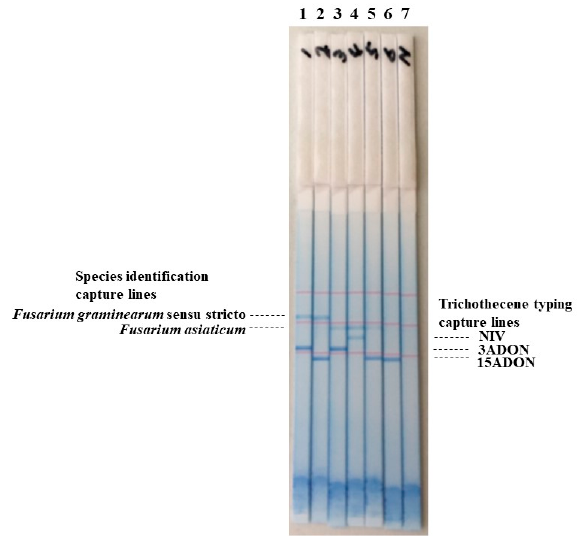
Figure 4. The dipstick DNA chromatography assay for species identification and trichothecene typing of the Fusarium graminearum species complex. Multiplex PCR solutions for species identification ( Fusarium graminearum sensu stricto [s. str.] and Fusarium asiaticum ) and trichothecene typing (3-acetyl deoxynivalenol, 3ADON; 15-acetyl deoxynivalenol, 15ADON; and nivalenol, NIV) were mixed and developed using dipstick DNA chromatography. Lane 1, Fg0101020 ( F. graminearum s. str./3ADON); lane 2, Fg0201201 ( F. graminearum s. str./15ADON); lane 3, Fa0244004 ( F. asiaticum /3ADON); lane 4, Fa0239005 ( F. asiaticum /NIV); lane 5, Fa0343747 ( F. asiaticum /15ADON); lane 6, Fv0301112 ( Fusarim vorosii /15ADON); lane 7, water control.